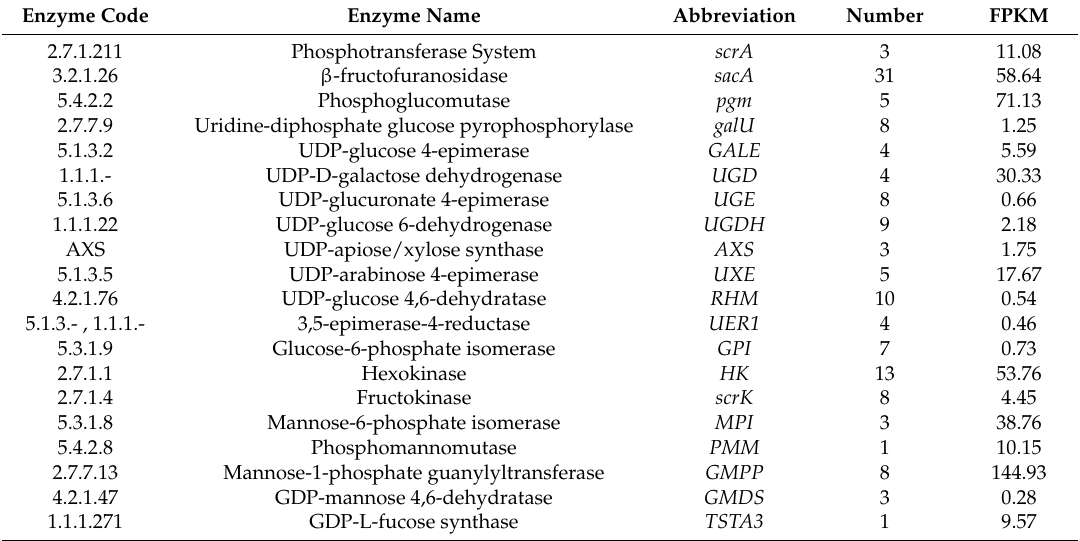
Table 6. Number of unigenes involved in the biosynthesis of starch and sucrose in Polygonatum sibiricum . Enzyme